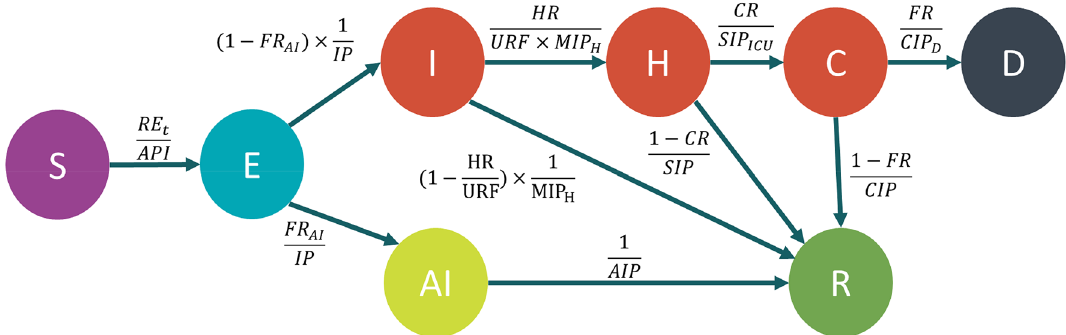
Figure. 2. Disease transmission model including Susceptible (S), Exposed (E), Infected (I), Asymptomatic Infection (AI), Hospitalization (H), Critical Infection (C), Recovery (R), and Death (D)